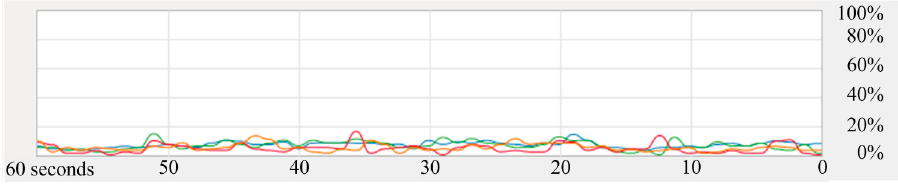
Figure 12. CPU history of the laptop that ran an MQTT publisher and MODBUS TCP server.